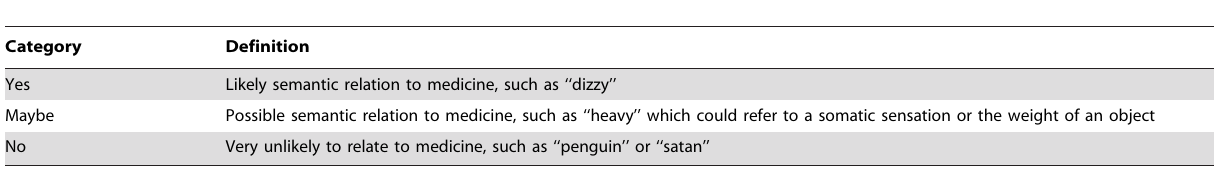
Table 3. Categories for stratifying words based on semantic relation to drug use.